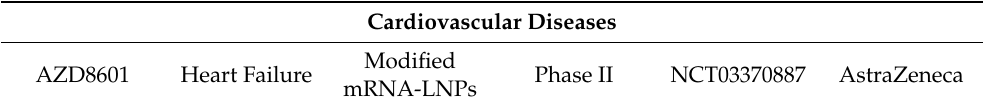
Table 5. mRNA Nanomedicines for cardiovascular diseases in Clinical Trials. A list of clinical trials for cardiovascular diseases is provided in this